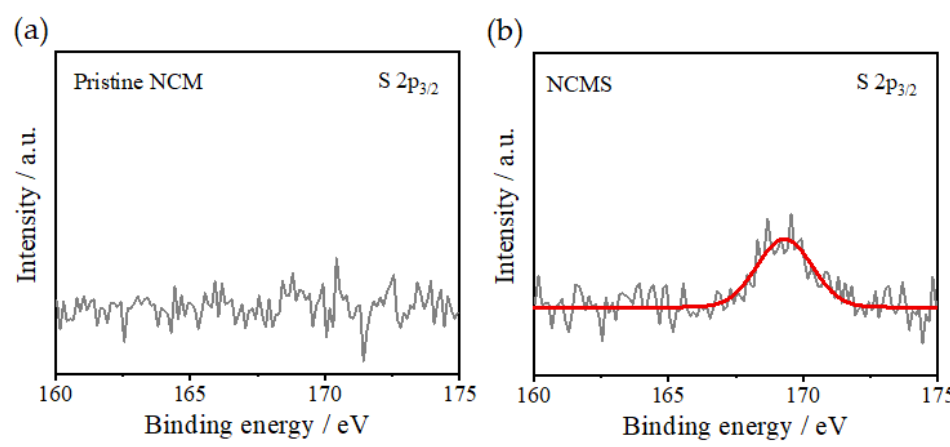
Figure 6. XPS profiles of the cathode active materials of ( a ) pristine NCM and ( b ) NCMS. The electrochemical performance of the charge-discharge profiles for pristine NCM and NCMS is presented in Figure 7a. For both samples, the C-rate during the charge was fixed at 0.1 C, while the C-rates during the discharge were varied from 0.1 to 5 C. Compared to pristine NCM, the discharge capacities of NCMS at each C-rate is slightly decreased. The discharge capacities at 0.1 C are 161.1 and 159.6 mAh g − 1 for pristine NCM and NCMS, respectively. During the initial charge to 4.3 V vs. Li/Li + , a gentle slope below 3.9 V occurs with the removal of lithium from NCM, which accompanies the oxidation of Ni 2+ /Ni 4+ and Co 3+ /Co 4+ [15]. Although the presence of sulfate was confirmed in the structural characterizations of NCMS, the decrease in its discharge capacity is not significant. The coulombic efficiencies are 99.4% and 99.7% at 0.1 C, 89.7% and 89.0% at 2 C, and 82.7% and 79.6% at 5 C for pristine and NCMS, respectively. These results indicate that excessive sulfate in NCM has a minimal effect on the reversibility in the Ni and Co redox system. The dQ/dV plots of pristine NCM and NCMS at 0.1, 2, and 5 C were obtained to examine the reversibility and redox overvoltage of the cathode active materials (Figure 7b). Both samples at 0.1 C display the reduction and oxidation peaks of Ni 4+ /Ni 2+ at 3.74 and 3.76 V, respectively. The reduction peaks gradually shift to lower potentials as the C-rate during the discharge increases. However, the difference in the position of reduction peaks is very small between pristine NCM and NCMS. The capacity retention of pristine NCM and NCMS cycled at 1 C showed superior cyclability over 98% after 50 cycles in both samples (see Figure S1). Therefore, considering that pristine NCM and NCMS have the same redox overvoltage and the cycle stability, the sulfate groups belonging to NCM would not seriously affect the reversibility of the cathode active